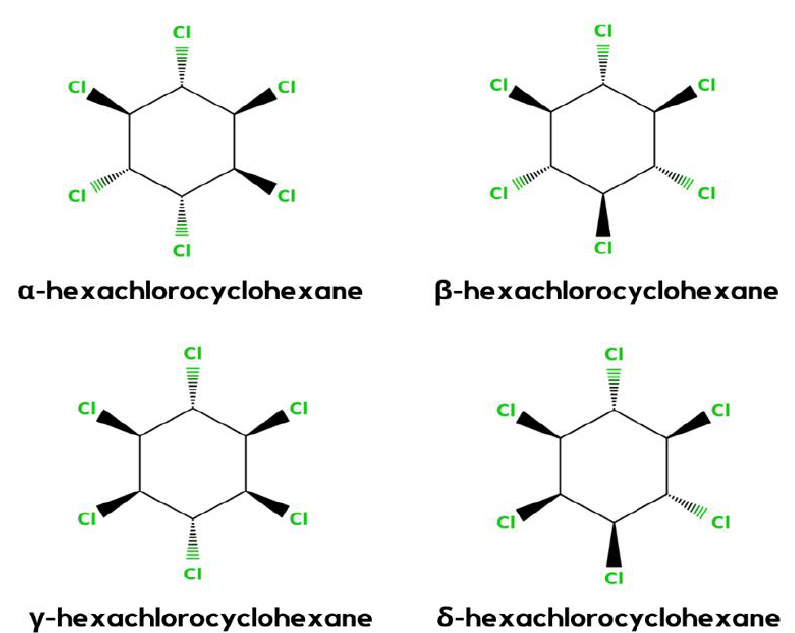
Figure 2. Different stereochemical structures of lindane (α, β, γ, and δ).